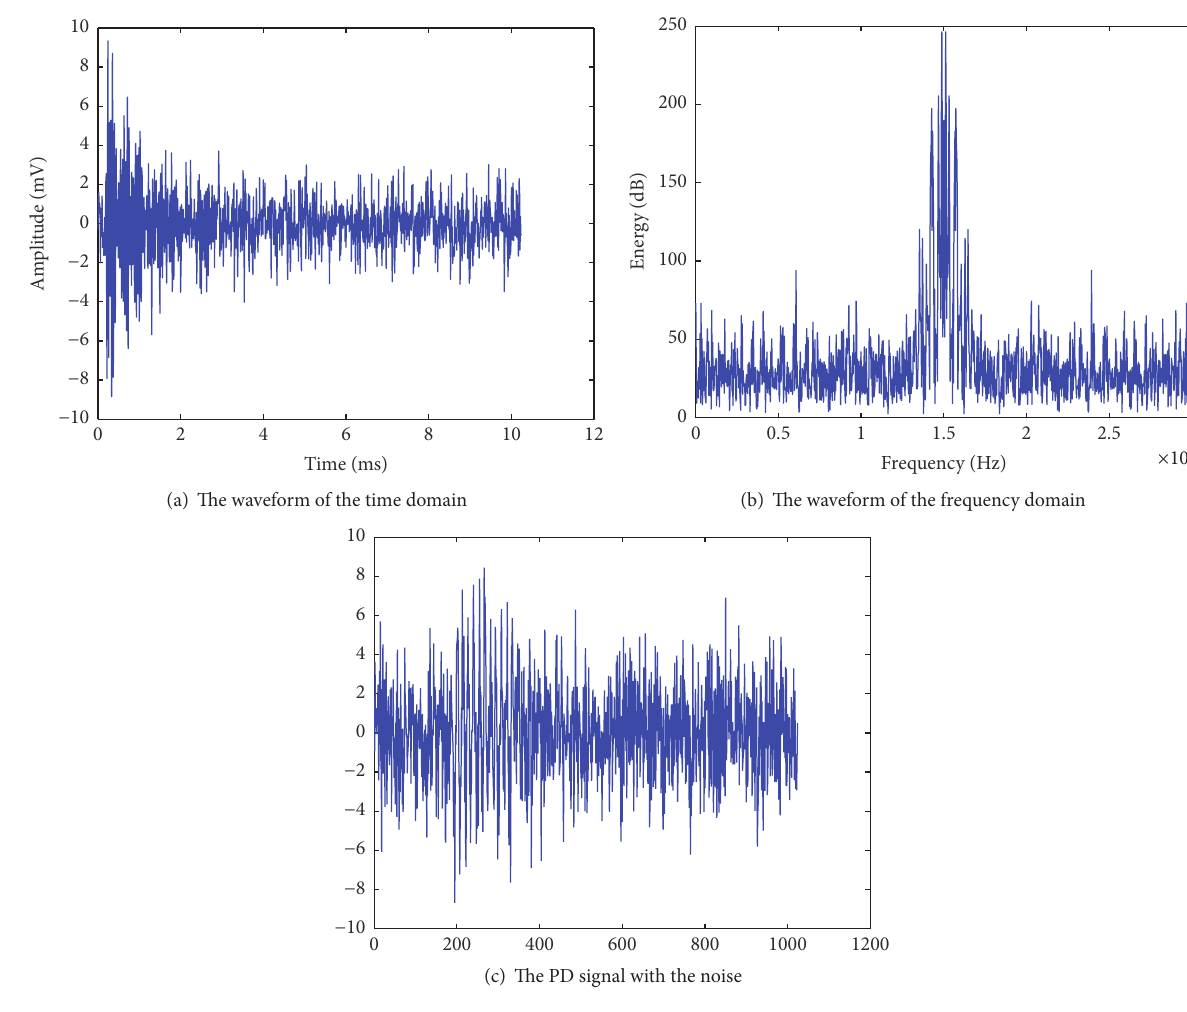
Figure 4: The simulated PD